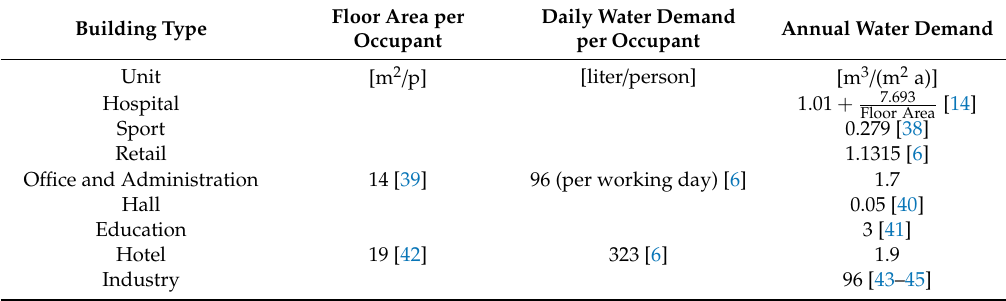
Table 4. Key parameters of water demand assessment in non-residential